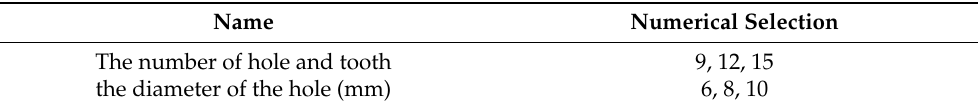
Table 1. Numeric